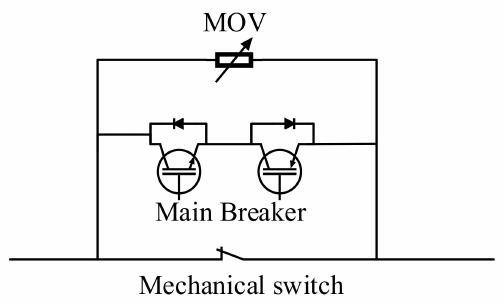
Figure 8. Structure of typical SSCBs.